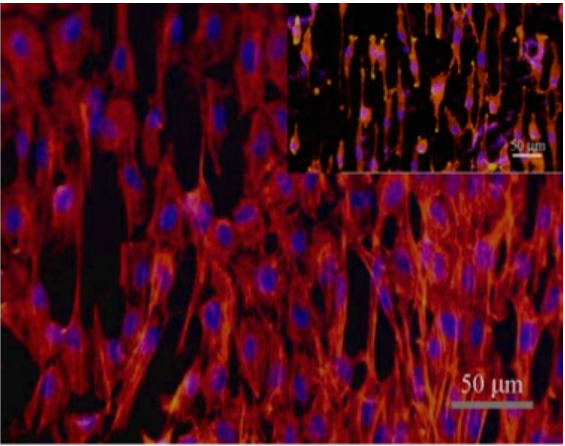
Figure 7. Endothelial cells cultured inside the micro-patterned polyurethane-based synthetic blood vessel after three days (reprinted from Ref. [40]).